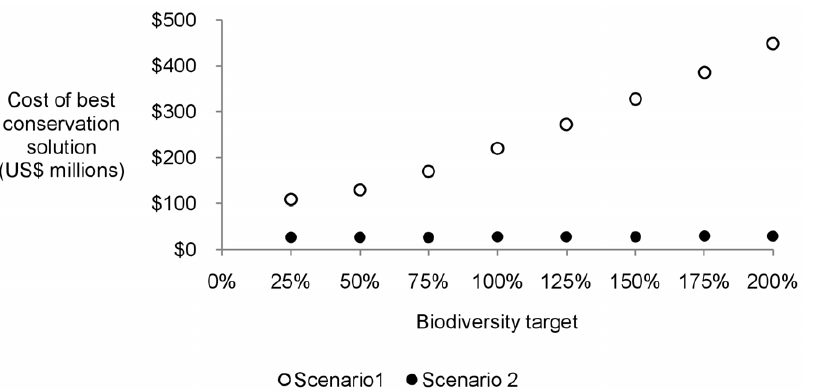
Figure 4. The least cost conservation solution generated by Marxan for Scenario 1 at a carbon price of US $ 14 tCO 2 -e increased steadily as the biodiversity target level was increased from 25% to 200% of the baseline targets. The cost for Scenario 2 (where carbon revenue is deducted from the cost of land stewardship) remained comparatively constant as the carbon captured increases with the larger biodiversity targets (Figure 5).